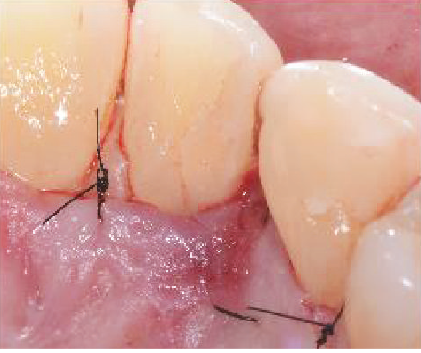
Figure 8: Single 5/0 and 6/0 sutures were